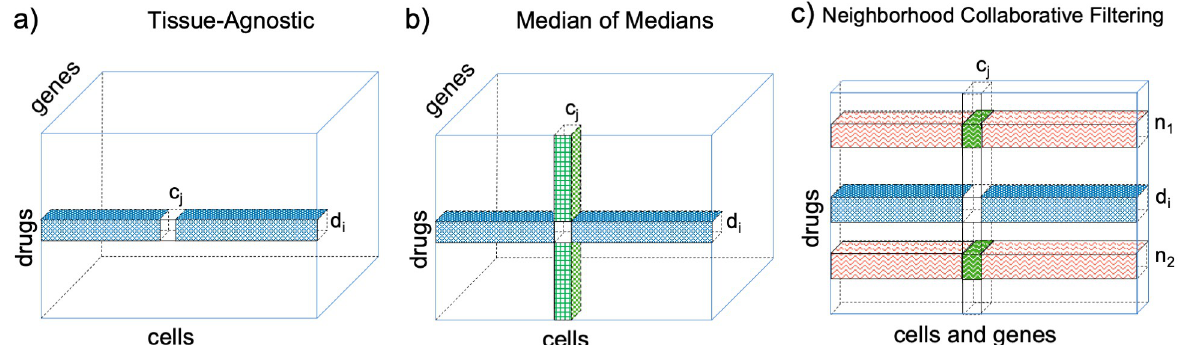
Fig 1. Methods overview. a) In Tissue-Agnostic imputation, the median of the expression of the first gene for drug d i in cells other than c j (the blue-colored row in the 3D matrix M) is used to predict the unknown expression profile for that cell/drug/gene combination (shown as a white missing value in the blue row). b) The Median of Medians ( MoM ) method predicts the same missing value by taking the median of two values: the median of that gene’s expression for drug d i in cells other than c j (the blue-colored row) and the median of that gene’s expression for drugs other than d in cell c (the green-checked column). c) In Neighborhood Collaborative Filtering, we use the flattened 2D matrix R , where rows contain i j values for all genes in cell 1, all genes in cell 2, and so on. Neighbors are drugs whose expression profiles on cells other than c j (orange waves) are most similar to drug d ’s profile on cells other than c (the blue-colored row). In this example with k = 2 neighbors, the expression profiles for cell c i j on neighbor drugs d n 1 and d n 2 (darker / green waves) are used to impute the missing profile for drug d i on cell c j